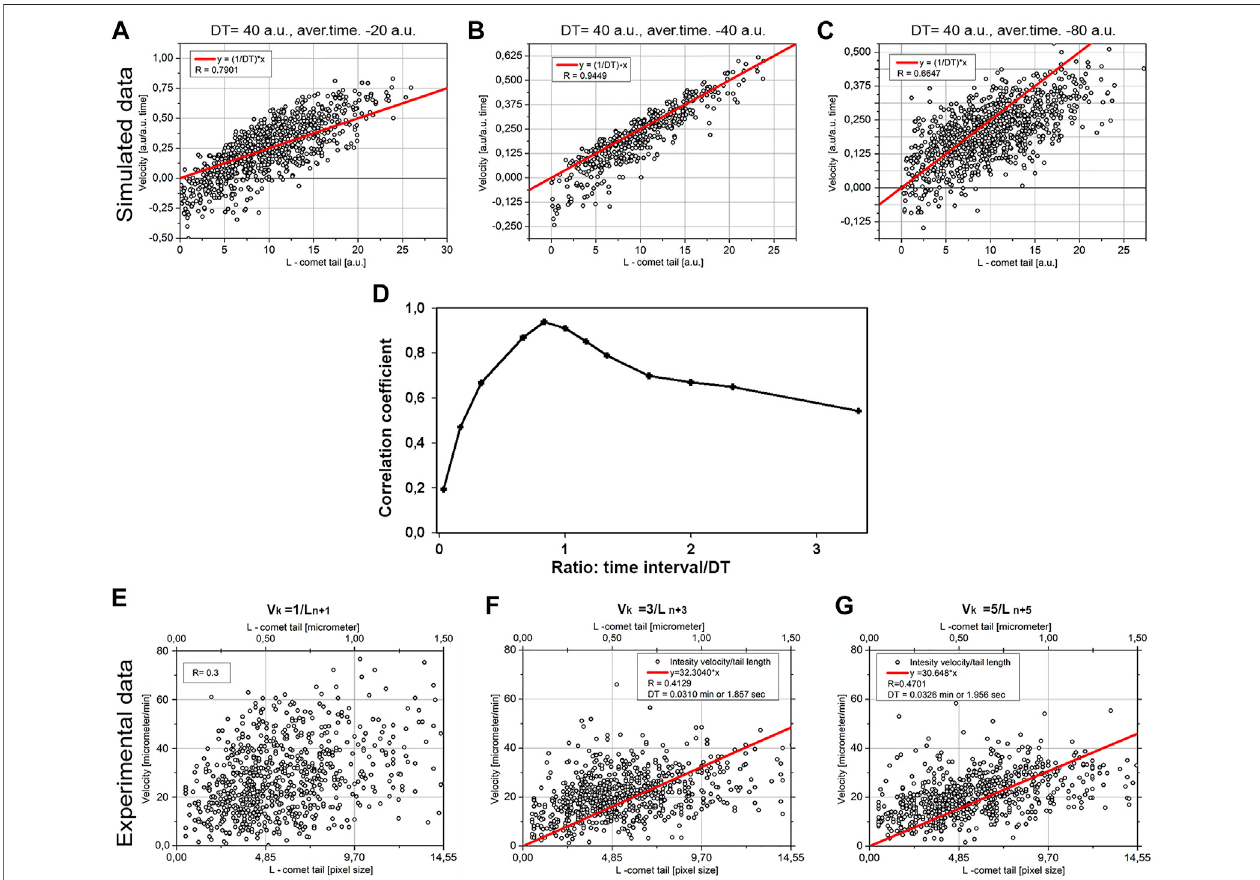
FIGURE 8 | Correlation between tail length and averaged velocity of MT elongation. The comparison of the simulated model data (A – C) and the experimental data (D – F) retrospectively. The model (A) DT (cid:1) 40 a.u., averaging time (cid:1) 20 a.u., (B) DT (cid:1) 40 a.u., averaging time (cid:1) 40 a.u., (C) DT (cid:1) 40 a.u., averaging time (cid:1) 80 a.u. The correlation of tail length/velocity for v k (cid:1) 1/L n+1 in experimental data (E) the correlation (R) for v k (cid:1) 3/L n+3 (F) , and correlation for v k (cid:1) 5/L n+5 (G) . For (F, G) the calculated regression line y (cid:1) ax also